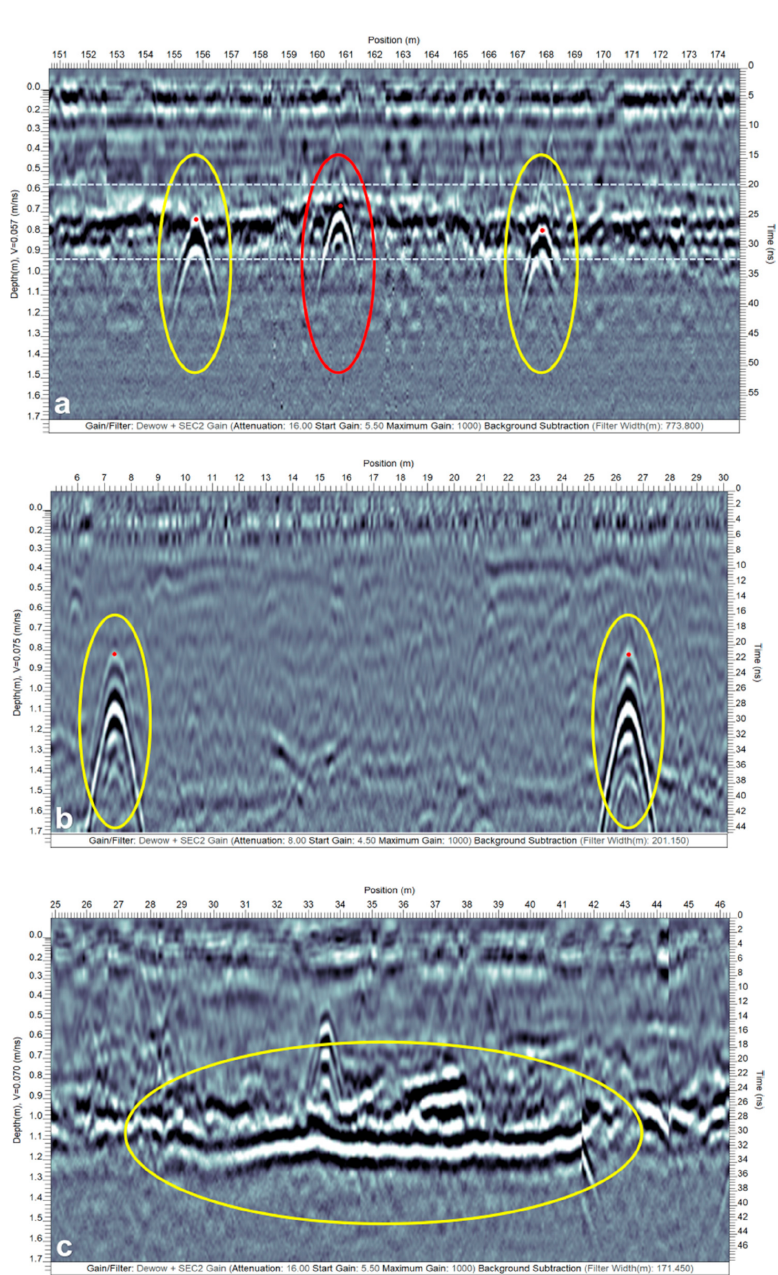
Figure 11. Drainage pipe response on the GPR profiles: ( a , b ) single (yellow and red) and dual (yellow) reflection hyperbolas result when the GPR traverse is perpendicular to the drainage pipe orientation (from Sites-1 and -3, respectively), and ( c ) banded linear feature (yellow) results when the GPR traverse is over the top and along the trend of the drainage pipe (from Site-2). In ( a ), the strong reflections from the water table due to a high RDP contrast are highlighted within the light blue dashed lines. Note that the red dots correspond to the actual location or top of the drain